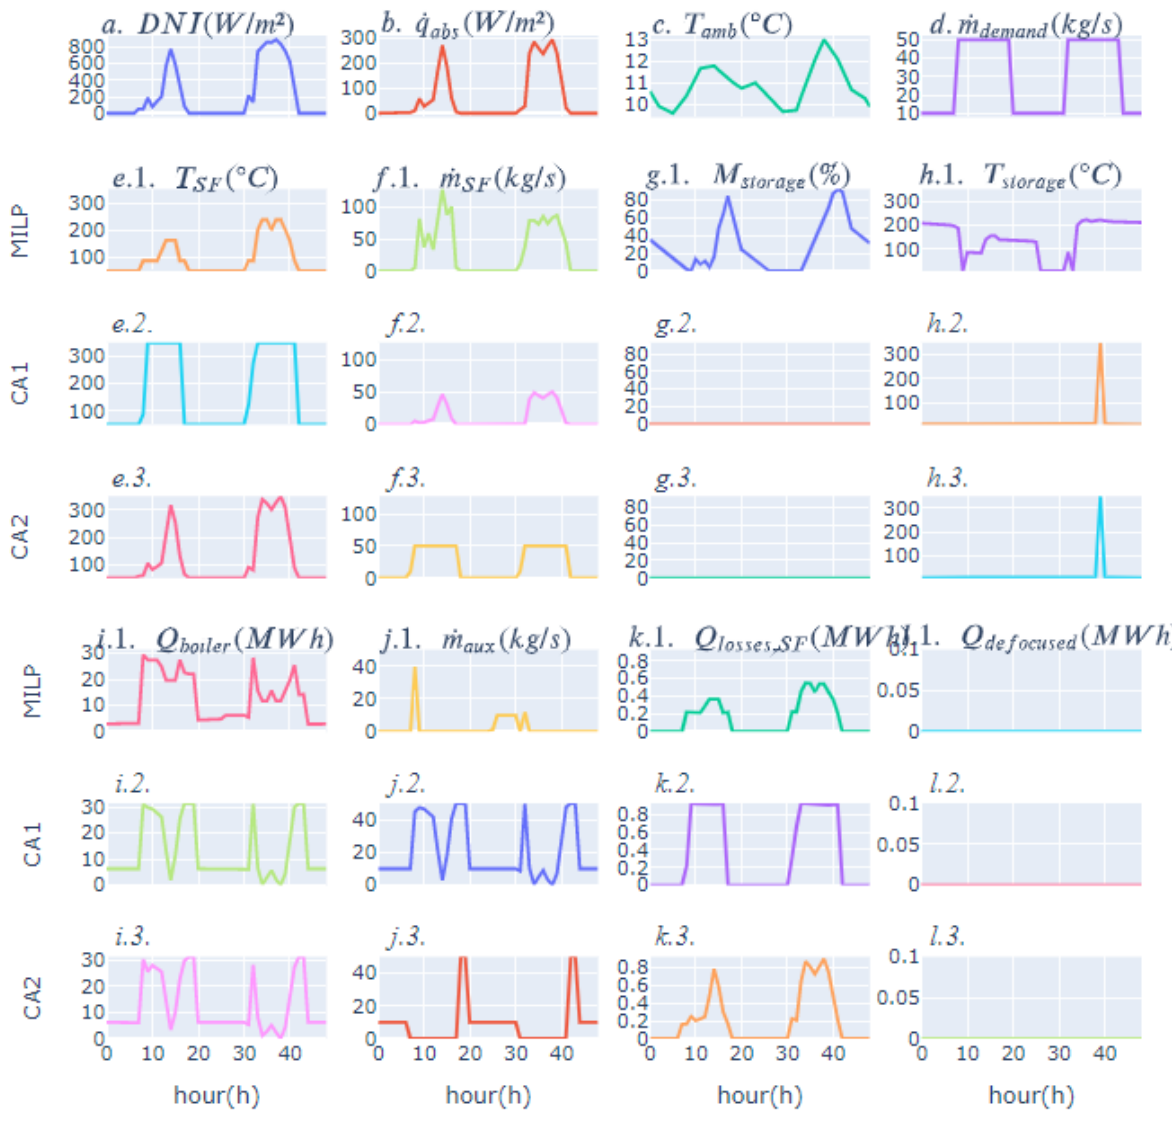
Figure 8. Simulation results in winter on 24th–25th of February.